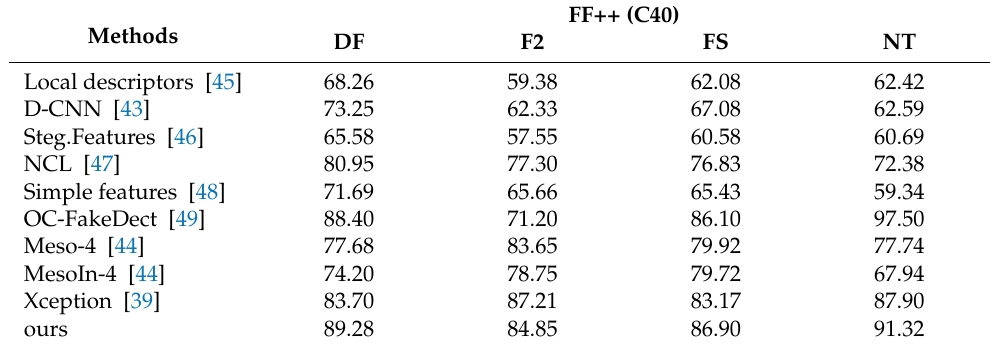
Table 3. The ACC results under high compression scene (C40) (%).